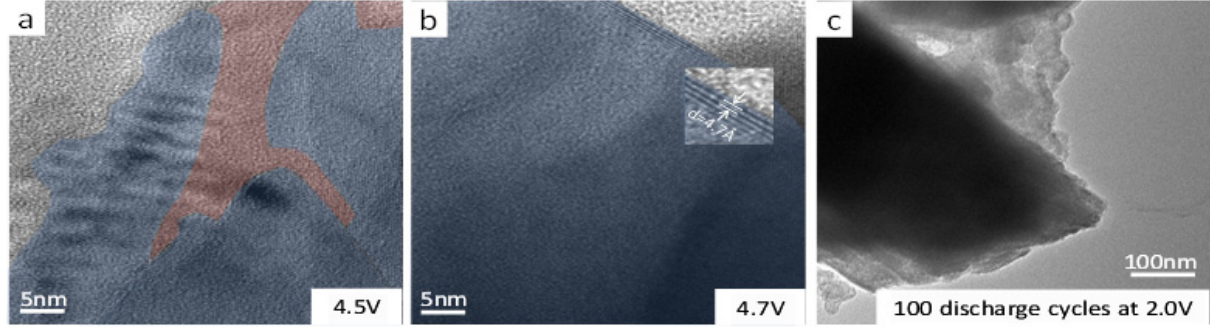
Figure 7. TEM micrographs of NMC262 after charging to ( a ) 4.5 V and ( b ) 4.7 V, and ( c ) after 100 cycles of discharge at 2.0 V.